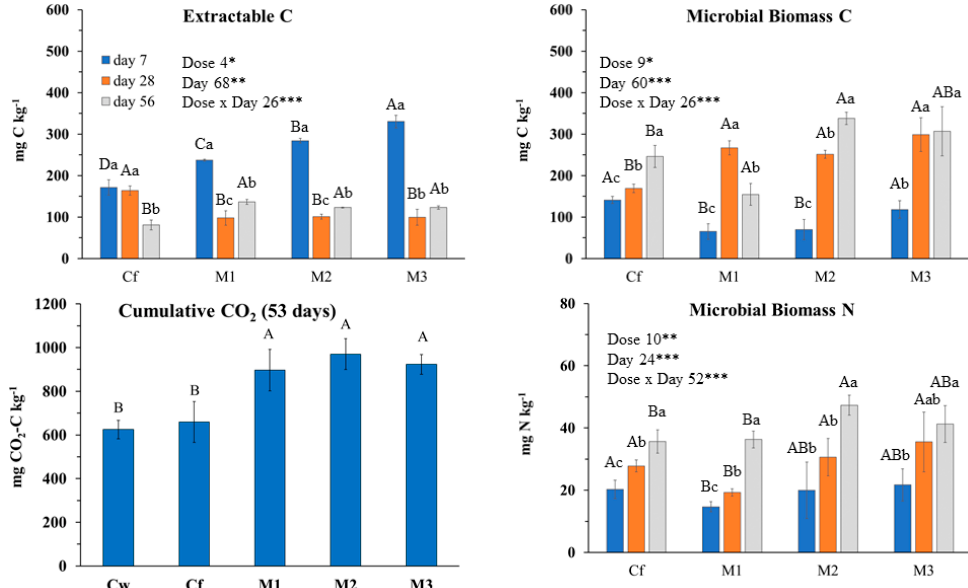
Figure 3. Biochemical soil variables determined at 7, 28 and 56 incubation days after Mentha × piperita L. essential oil applied by irrigation at different concentrations: Cw (no Fitoil and EO application), Cf (0.03 µL Fitoil g − 1 of soil and no EO application), T1 (0.03 µL Fitoil g − 1 of soil and 0.31 µL EO g − 1 of soil), T2 (0.03 µL Fitoil g − 1 of soil and 0.67 µL EO g − 1 of soil), and T3 (0.03 µL Fitoil g − 1 of soil and 0.93 µL EO g − 1 of soil). Reported results are means ± standard deviations ( n = 4). The percentage of variance explained by incubation day, dose of essential oil and by their interaction are also reported. Capital letters indicate significant differences among doses within the same incubation day. Lower case letters indicate significant differences among incubation days within the same dose. *, ** and *** indicate significant at p < 0.05, p < 0.01 and p < 0.001; NS, not significant.